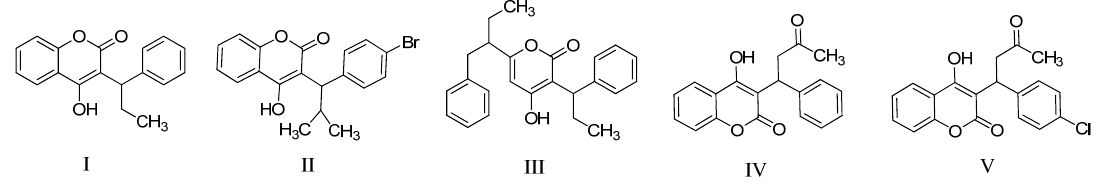
Figure 1. Examples of biologically active 4-hydroxycoumarin derivatives.